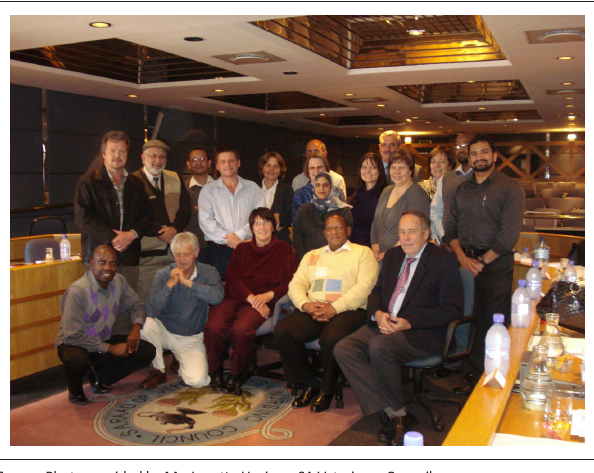
Absent: Mr Johann Muller. FIGURE 2: South African Veterinary Council,